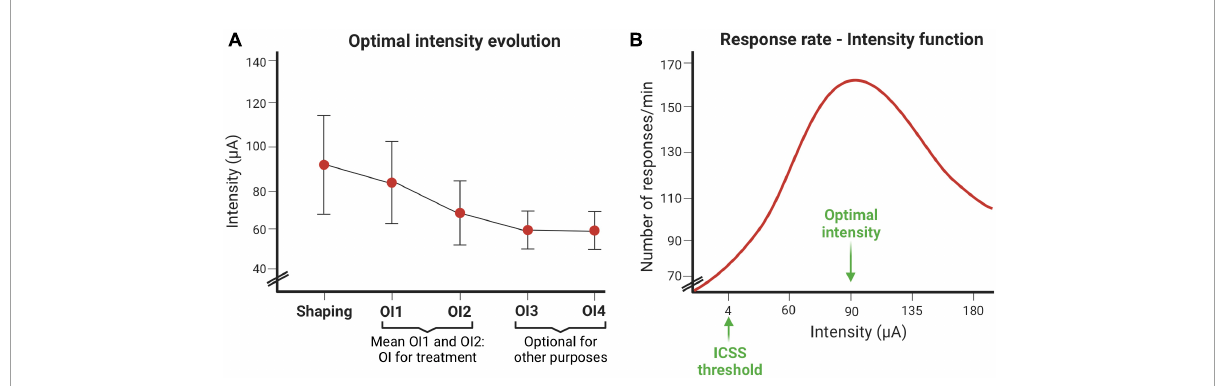
FIGURE11 Intracranial electrical self-stimulation (ICSS) variables evolution. (A) Optimal intensity evolution throughout the shaping session and the optimal intensity establishment sessions. (B) Response rate depends on the intensity ( µ A) used.